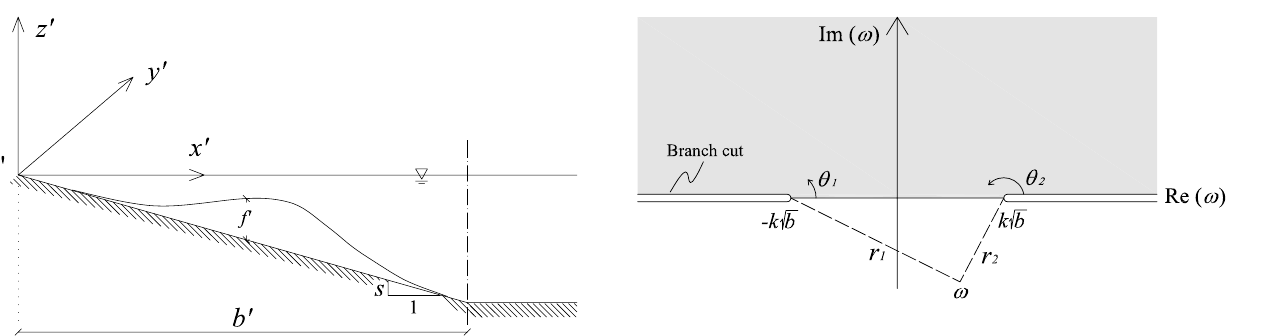
Fig. 9. The fluid domain of the semi-plane beach in physical coor- dinates. The dashed line divides the near field x 0 < b 0 from the far field x 0 >b 0 .